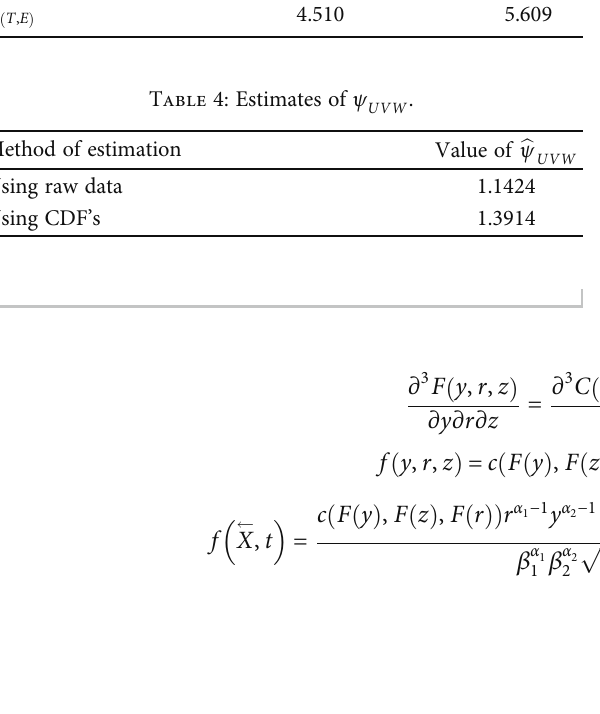
Table 4: Estimates of ψ